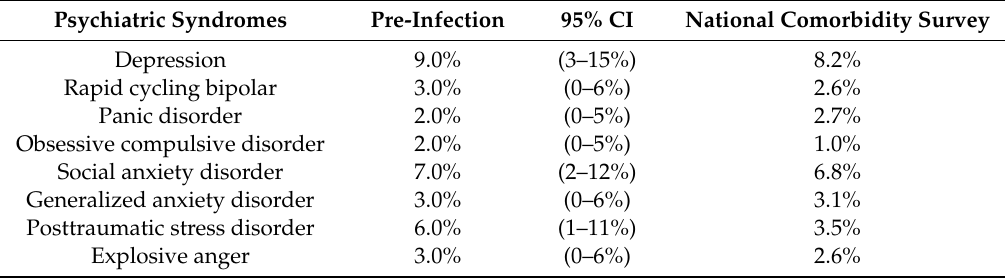
Table 2. Pre-infection prevalence of mental disorders in the patients studied compared to the prevalence of the same disorders in the 12 month National Comorbidity Replication